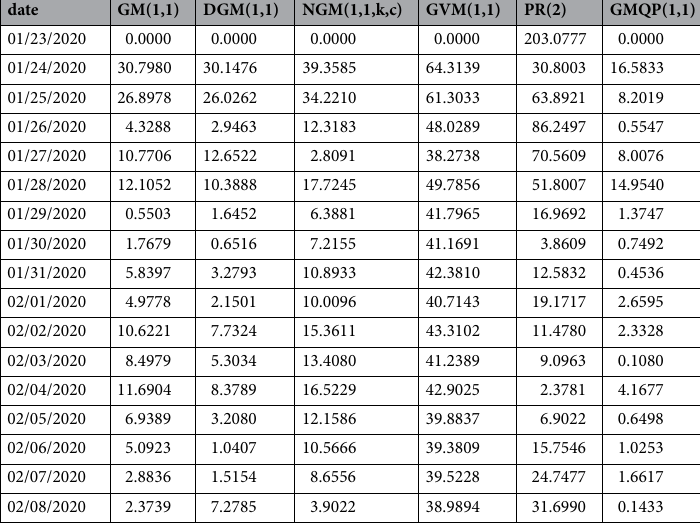
Table 16. The Errors of different model in the recovered cases of COVID-19 of China, (%).